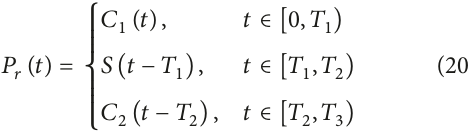
Figure 3: Divisions of the C segments. The minor C segment case is 󵱰𝑃 𝑃 𝑚 1 2 , the semicircular C segment is 󵱰 𝑃 𝑃 𝑗 is 1 2